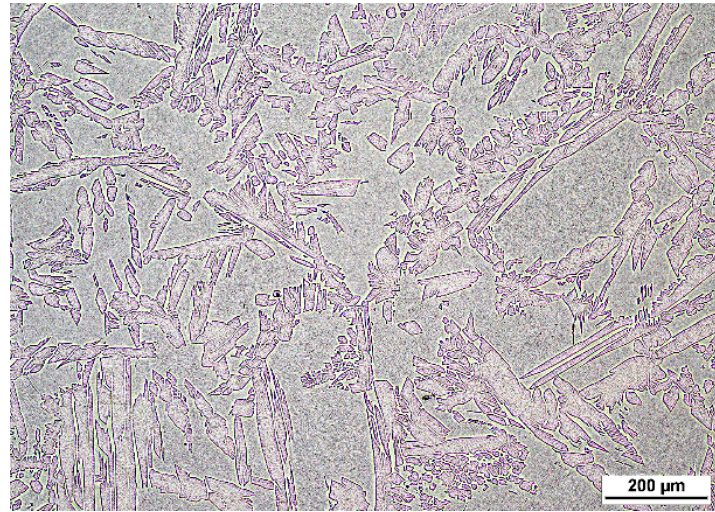
Figure 3. Optical microscopy of S32101 DSS cast with δ matrix and γ island structures.